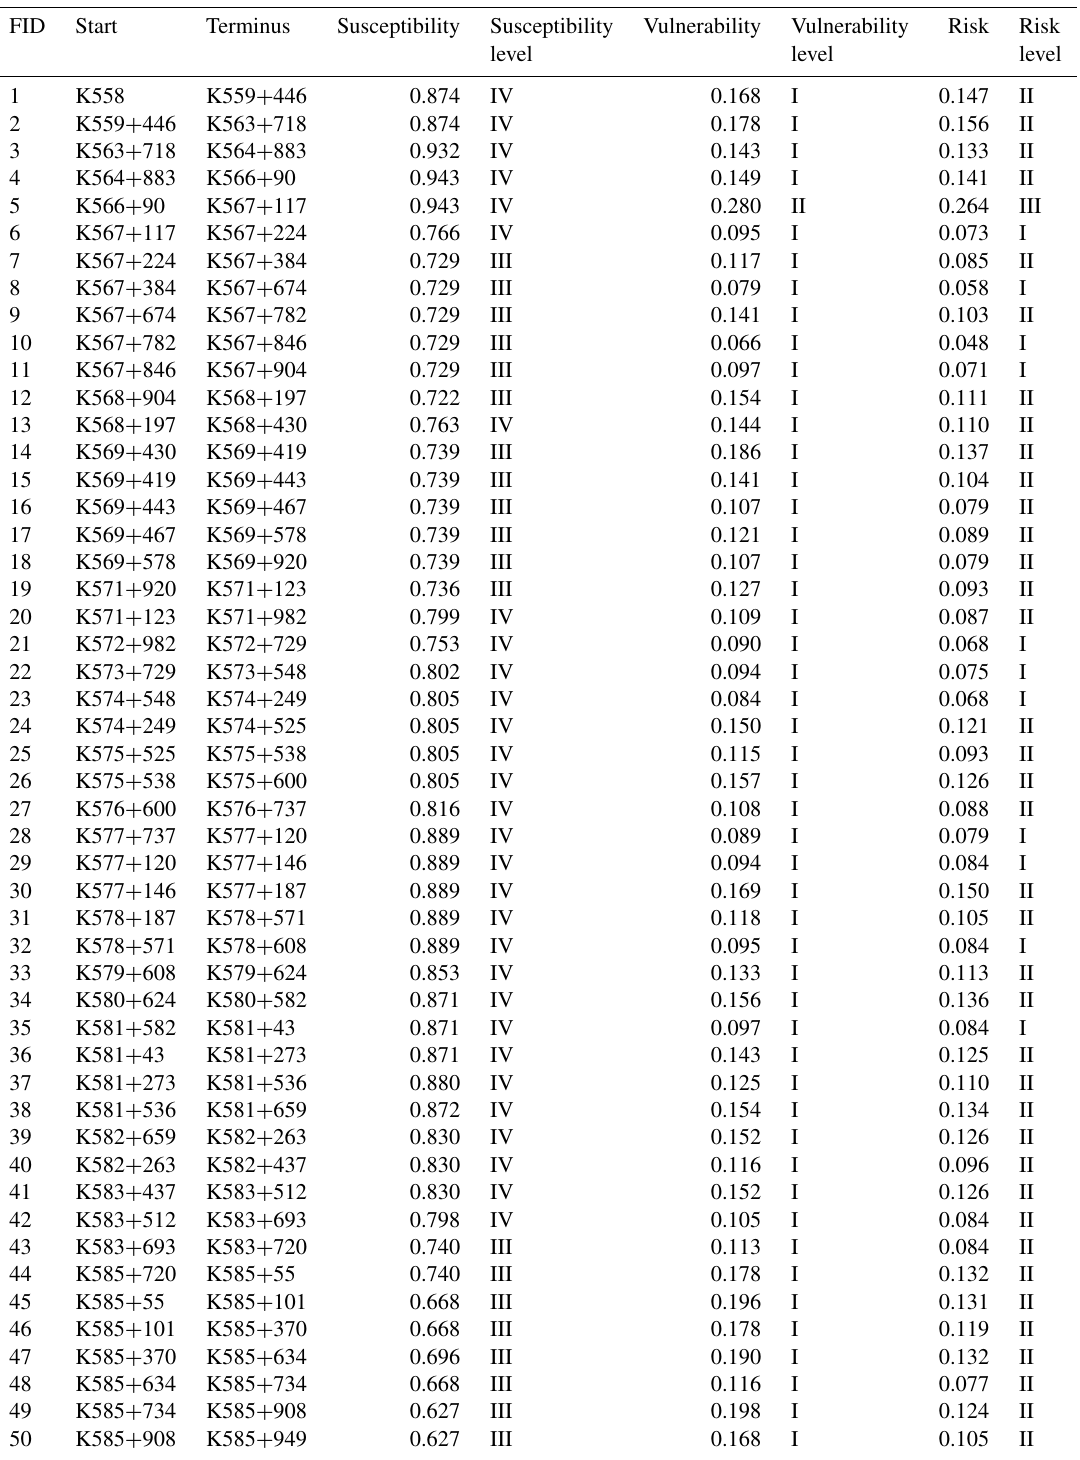
Table G1. Pipeline landslide risk assessment